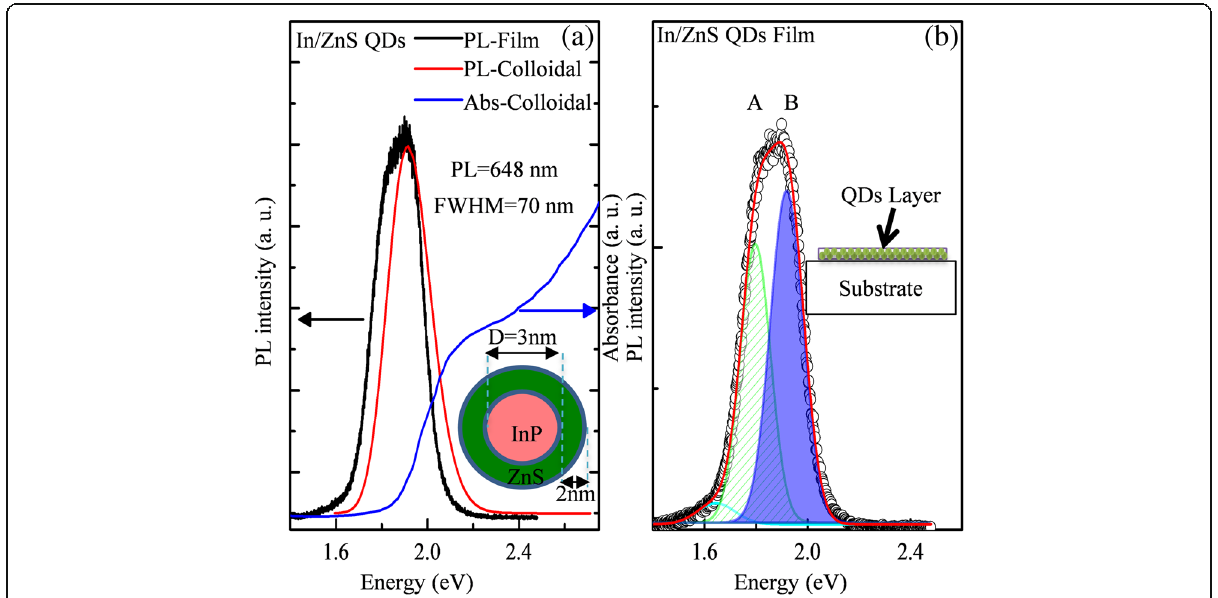
Fig. 1 a PL spectra of InP/ZnS QD film (untreated) (black line) and QDs in colloidal solution (red line). Absorption spectrum of the colloidal QDs